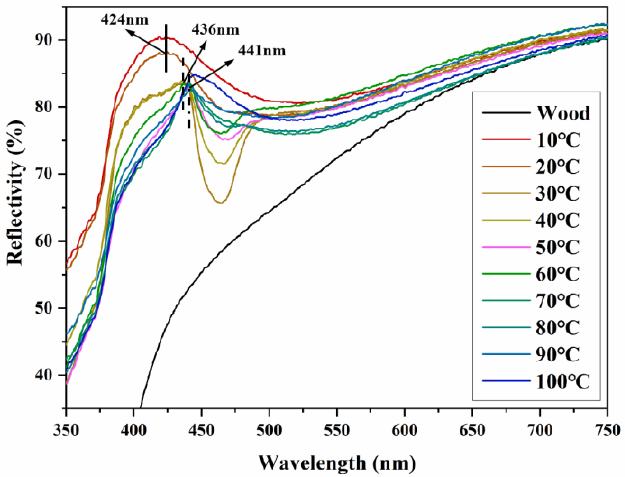
Figure 12. Reflection spectra of coatings formed by the self-assembly of PSt microspheres at different